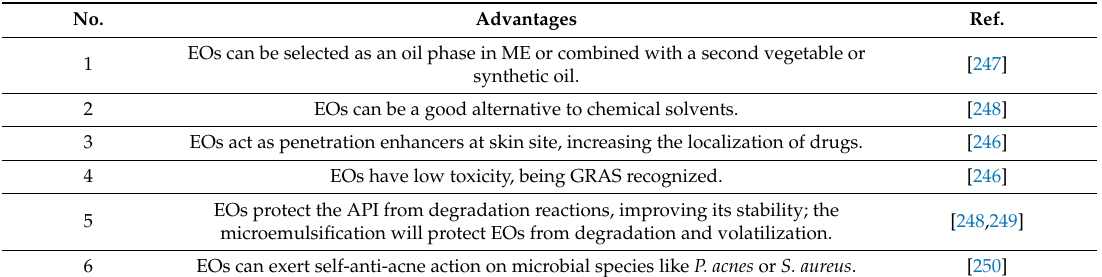
Table 3. Advantages of essential oils (EOs) and their impact on anti-acne microemulsion formulation.